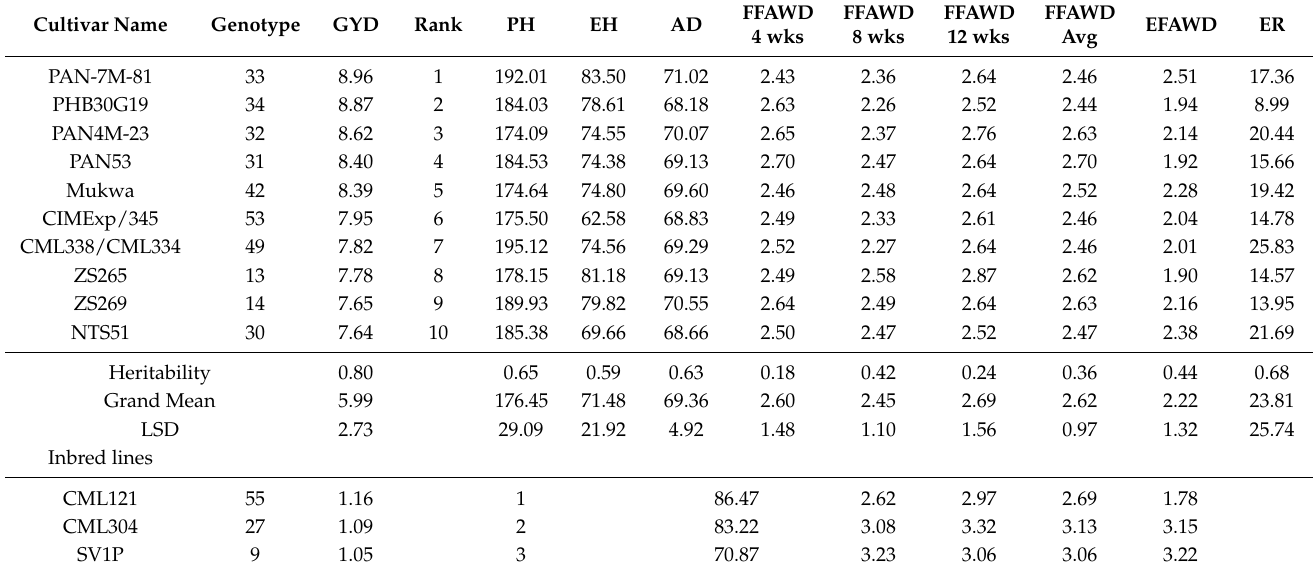
Table 6. Grain yield and agronomic performance of the best ten cultivars and experimental hybrids and best ten inbred lines evaluated under managed fall armyworm conditions in Zimbabwe